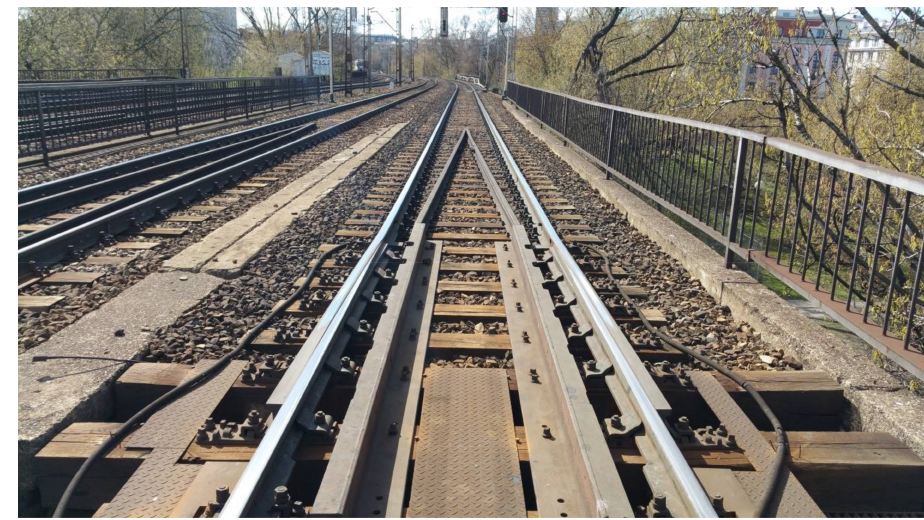
Figure 5. Breathing section of track No. 2 at km 2.100 (source: photo made by Jacek Makowski). Measurement bases, where longitudinal forces and rail temperature measurements were made, were located on the analyzed test section according to Figure 6.